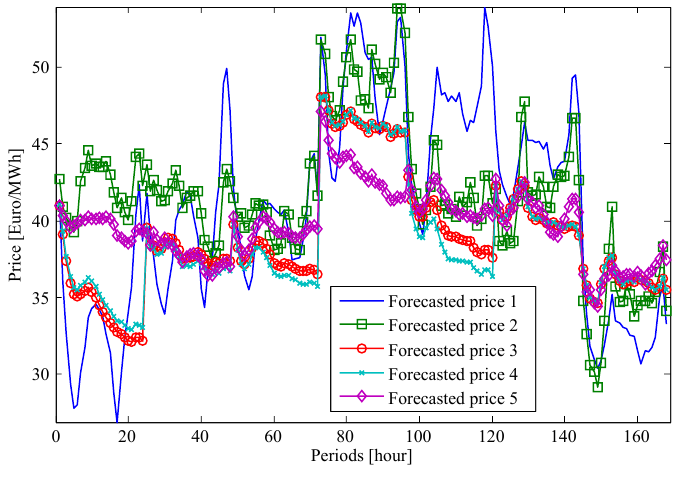
Figure 6. Input data of forecasted prices.